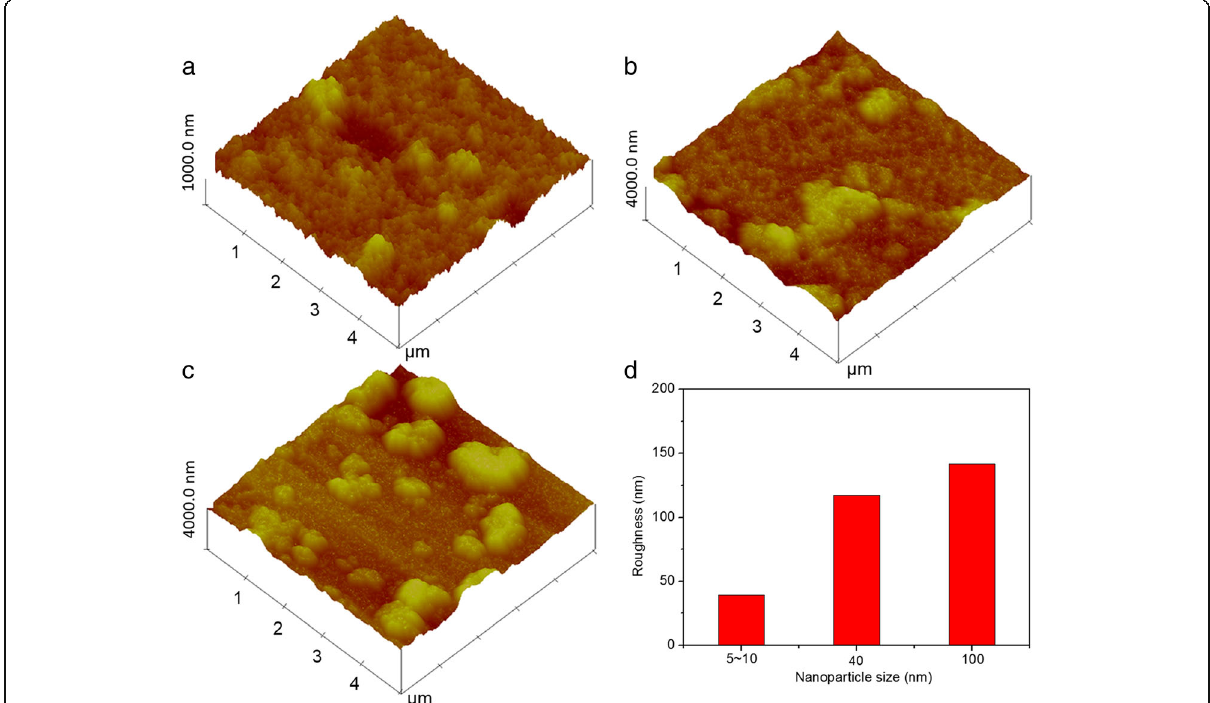
Fig. 3 (Color online) AFM images of TiO 2 thin film prepared with nanoparticle sizes of a 5~10, b 40, and c 100 nm and d roughness of TiO 2 thin film as a function of TiO 2 nanoparticle